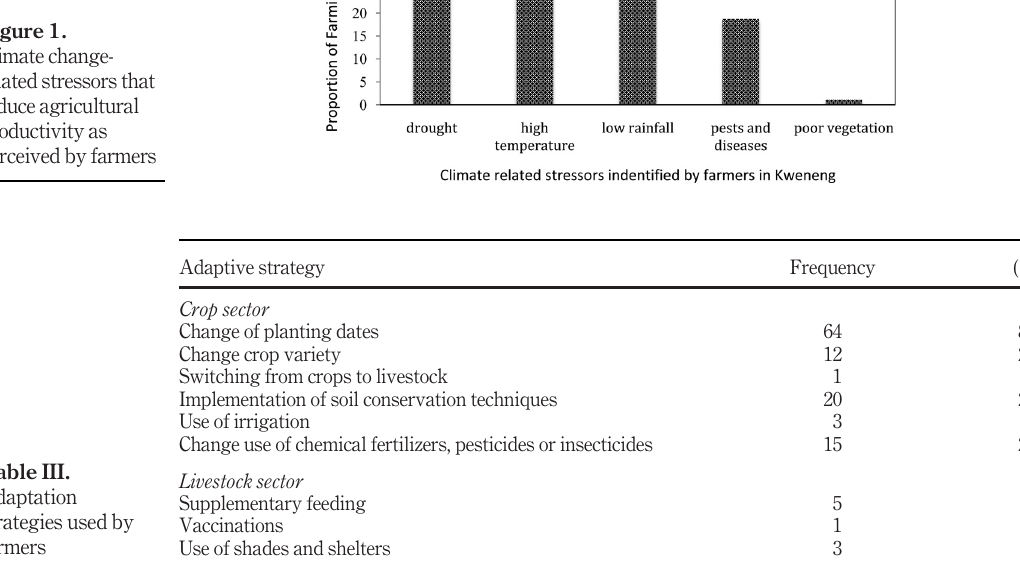
Table III. Adaptation strategies used by farmers